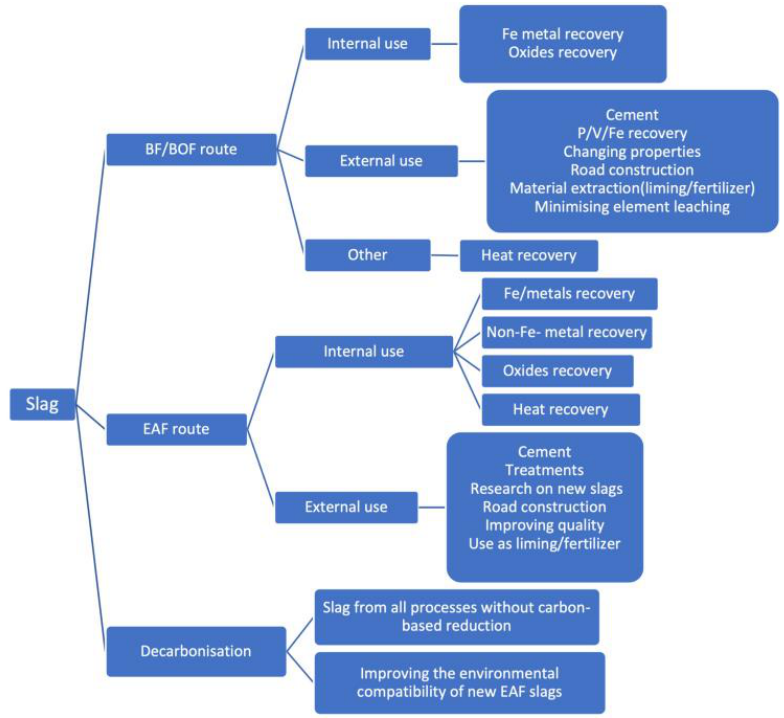
Figure 9. Future research needs on slag.